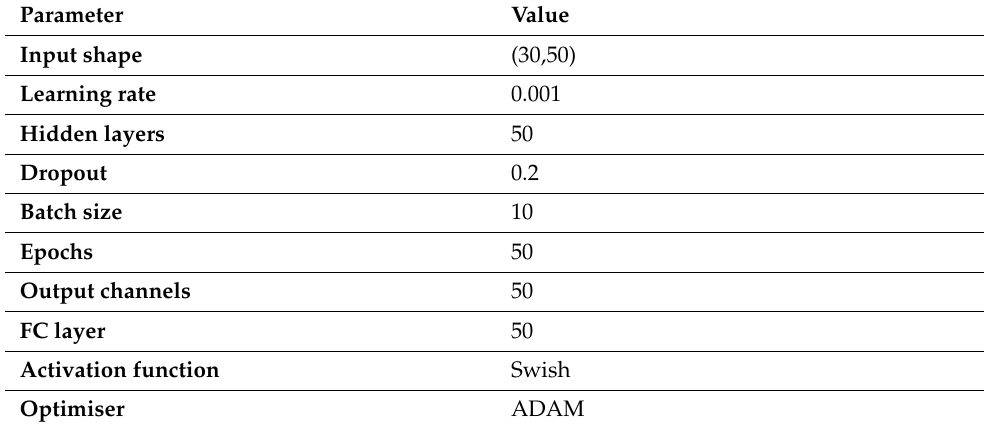
Table 2. Parameters details of